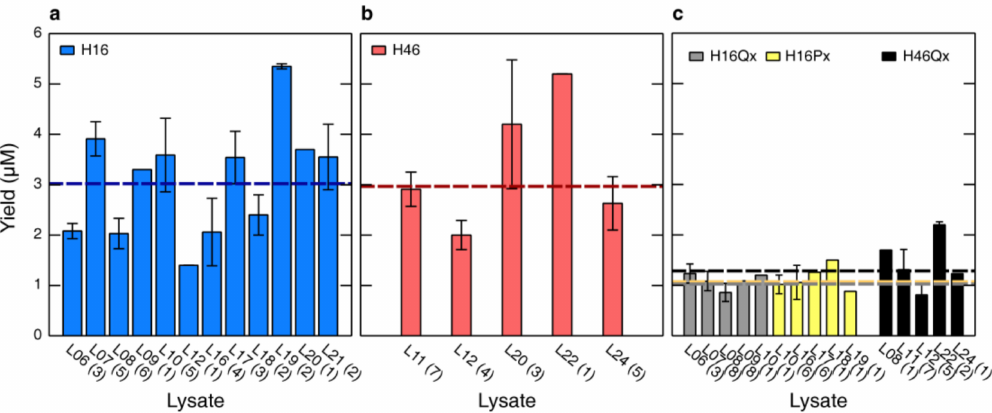
Figure 4. HttEx1 production variability across di ff erent lysates. Average CF yields obtained with di ff erent lysate batches for ( a ) H16 and ( b ) H46. The mean yield across all samples is shown as a dashed line. ( c ) Average yields obtained for SSIL samples of H16 Gln (gray), H16 Pro (yellow) and H46 Gln (black). The mean yield across all samples is shown as gray, yellow and black dashed lines, respectively. In all panels, the lysate batch and the number of samples prepared in the respective lysate are given (e.g., L06